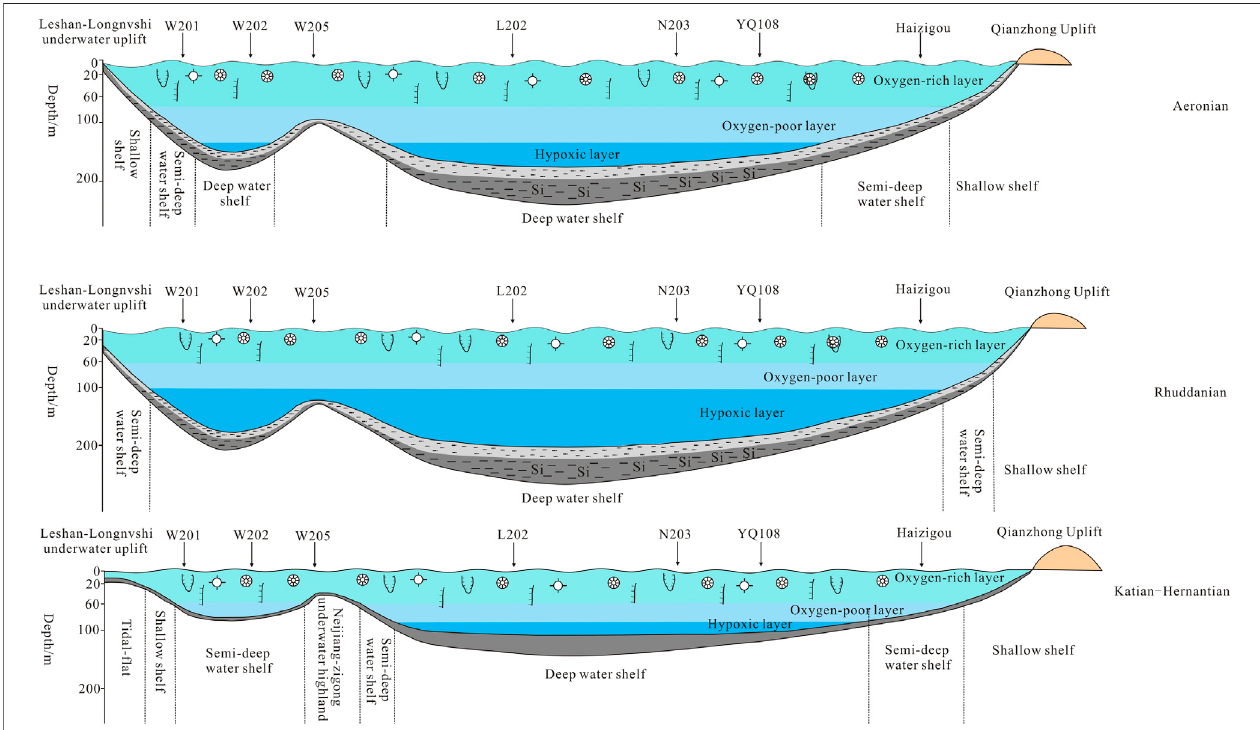
FIGURE 6 | Evolutionary model of the sedimentary environment in the depositional stage of the lower Silurian Longmaxi Formation in the southern Sichuan Basin (modi fi ed according to Pu et al., 2020).